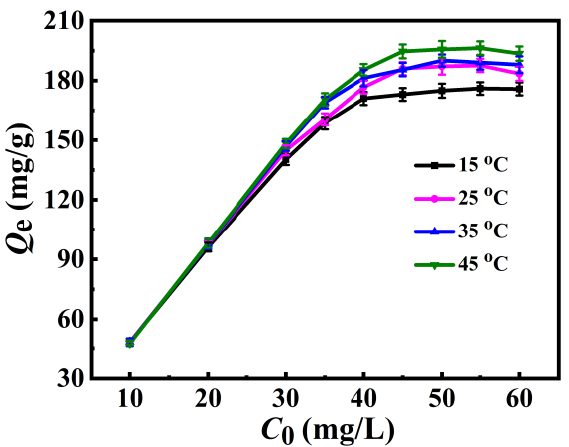
Figure 5. Influence of initial concentration of F − on the defluoridation performance of LMF11 NFs.